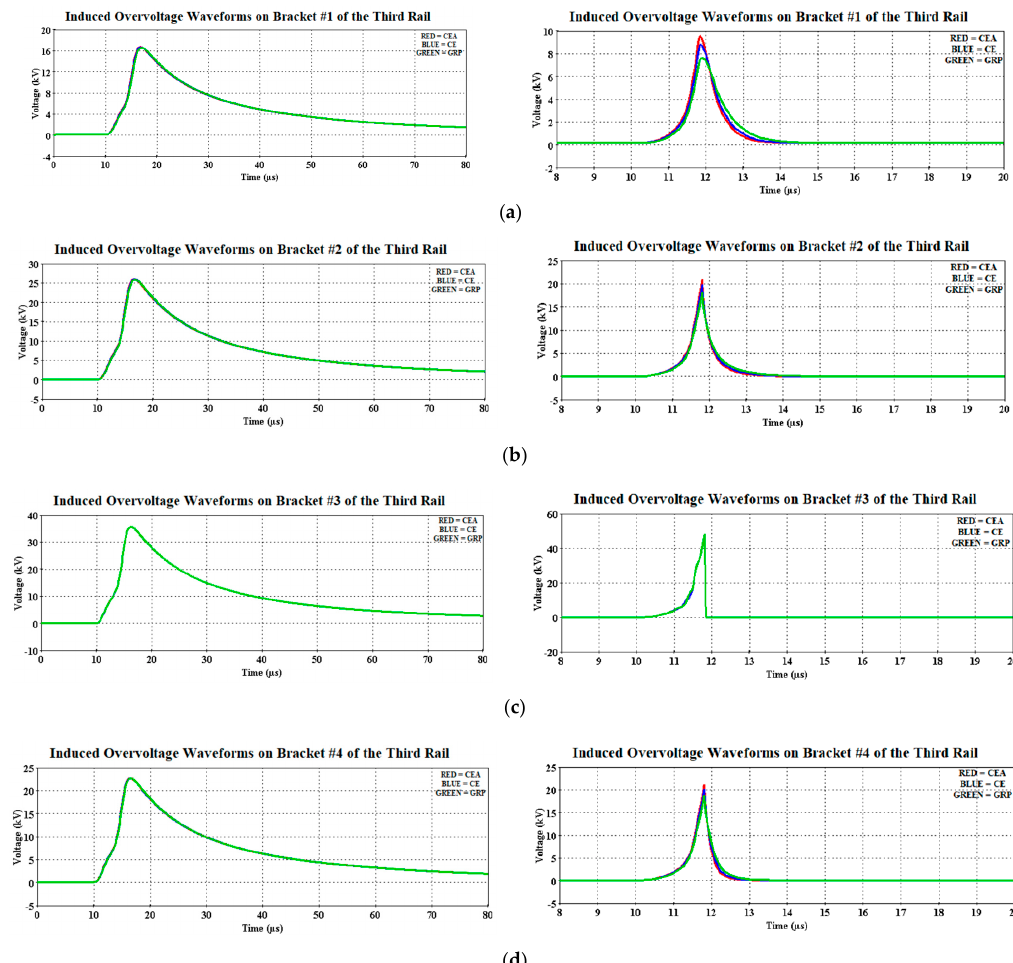
Figure 7. Induced overvoltage waveforms on the insulated rail brackets, i.e., ( a ) first bracket, ( b ) second bracket, ( c ) third bracket, and ( d ) fourth bracket, for both 30 kA ( left ) and 90 kA ( right ). It was observed that the induced voltages on the brackets due to 30 kA were not much different from one another as compared with the ones caused by the 90 kA, in par- ticular on the third bracket (Bracket #3). Figure 8 shows the magnified peak induced over- voltage, with the solid red, blue, and green lines representing the CEA, CE, and GRP ma- terials, respectively. Whilst Figure 9 shows the corresponding magnitudes obtained based on Figure 8. Note that the solid green waveform in Figures 7 and 8c represents the super- imposed waveforms for other materials and this applies to all the solid green waveform results obtained in this study. Since the impact of transient induced overvoltage has no influence on the perfor- mance of the fourth rail, further analysis of the fourth rail will not be discussed in this paper. The credible explanation that can be inferred is that the return stroke current model and the model function parameters as tabulated in Table 1 are the representation of a neg- ative first return stroke current, hence explaining the dismissive reaction of the fourth rail towards the induced overvoltage. Figure 8 shows the distinction between the bracket material performances when im- posed with 30 kA (5/80 µs) and 90 kA (9/200 µs) waveforms, where different magnitudes of the induced overvoltage were observed. Note that the CE bracket was made as the ref- erence case when comparing its performance with the CEA and GRP brackets. For exam- ple, all the three materials show the same magnitude of induced overvoltages recorded at the third bracket, due to their close distances to the lightning strike location and conse- quently experienced the highest induced overvoltage of 35.62 kV, before parting ways